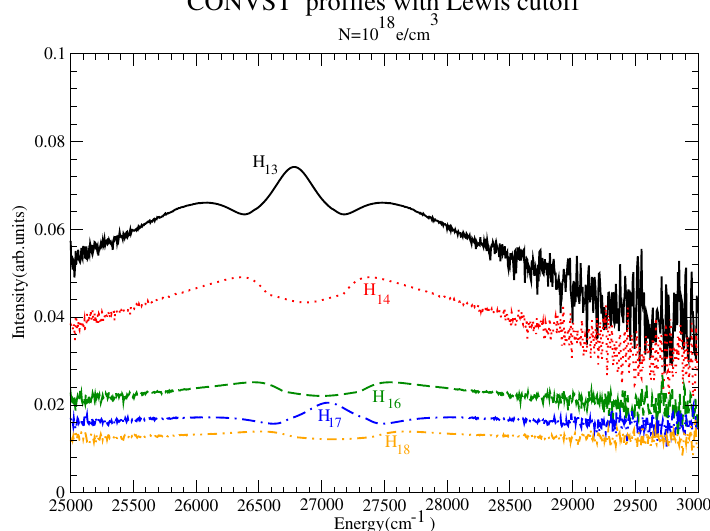
Figure 31. Intensity comparison for Balmer 13 to Balmer 18 at the intermediate density. Shown are CONVST profiles for H 13 (solid black), H 14 (dotted red), H 16 (dashed green), H 17 (dash-dotted blue) and H 18 (dash-double dotted orange).